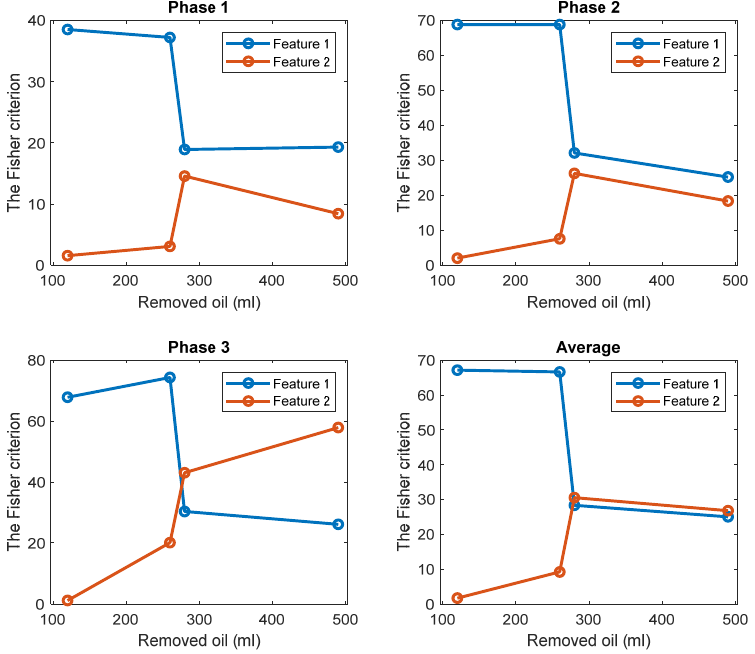
Figure 15. The FC of Feature 1 and Feature 2 respectively, for three phases and 4 levels of oil removal compared to the standard oil level (Day 1).